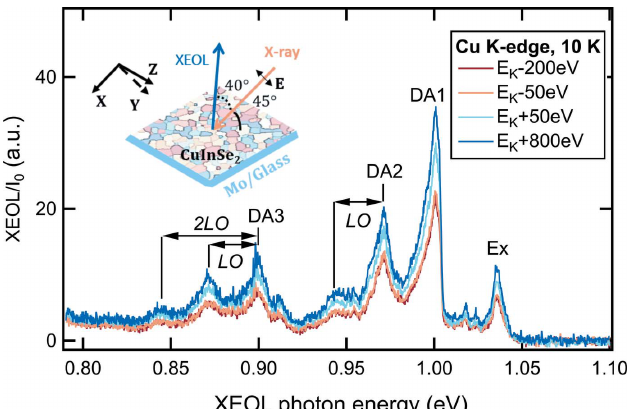
Figure 2 Normalized XEOL spectra measured at several selected X-ray energies across the Cu K -edge ( E K = 8979 eV) at 10 K on a polycrystalline CuInSe 2 thin film grown on a Mo-coated soda-lime glass substrate. The inset schematically illustrates the polycrystalline character of the sample with color code, the sample orientation relative to the polarization vector E of the incident X-ray beam and the direction of the collected XEOL signal. The assignments of the emission bands are based on PL studies (Babbe et al. , 2019; Spindler et al. , 2019), with the definition of the abbreviations given in Section